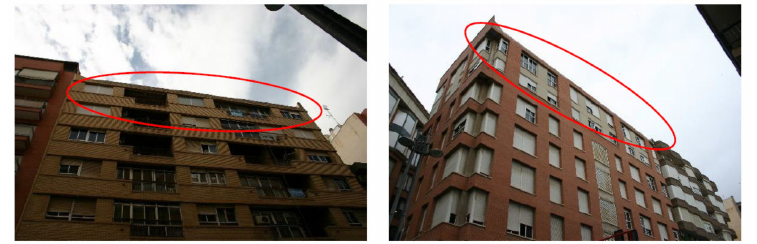
Figure 18. Examples of masonry parapets collapses in the Lorca (Spain) earthquake (adapted from Rom ã o et al.